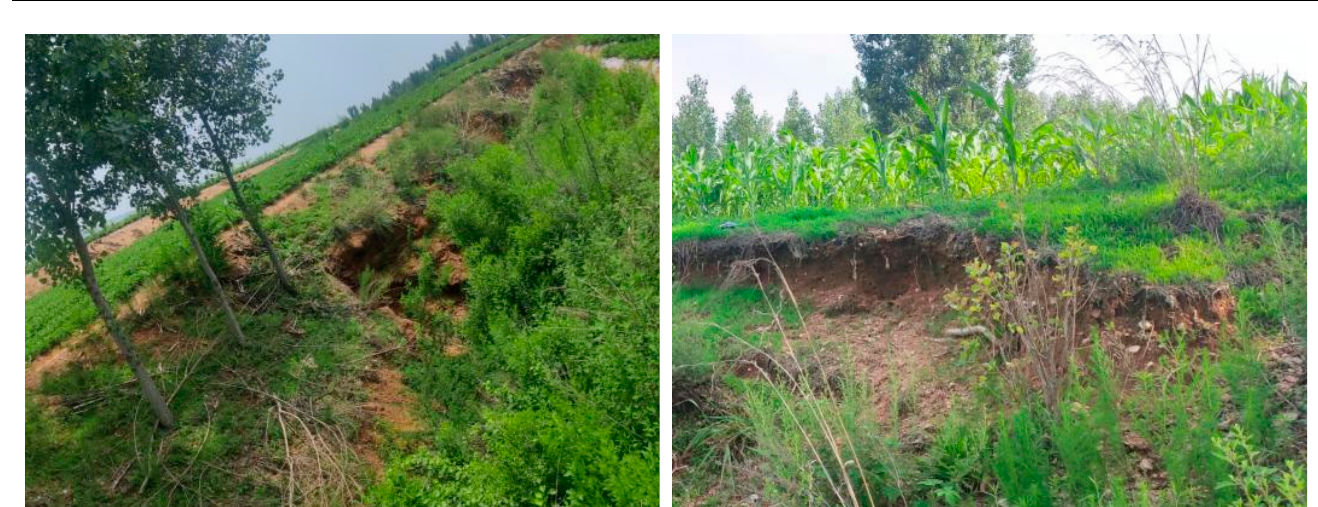
Figure 11. An example of lateral erosion and downcutting erosion in a gully.